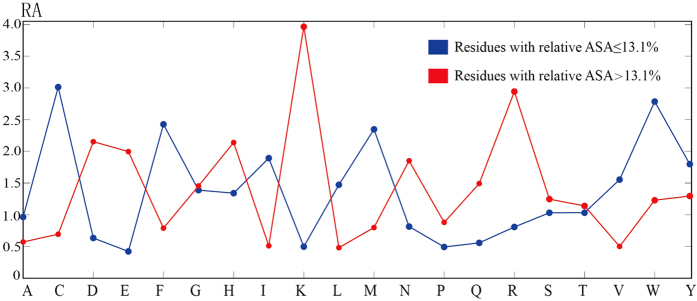
MF-RA for 20 amino acids.